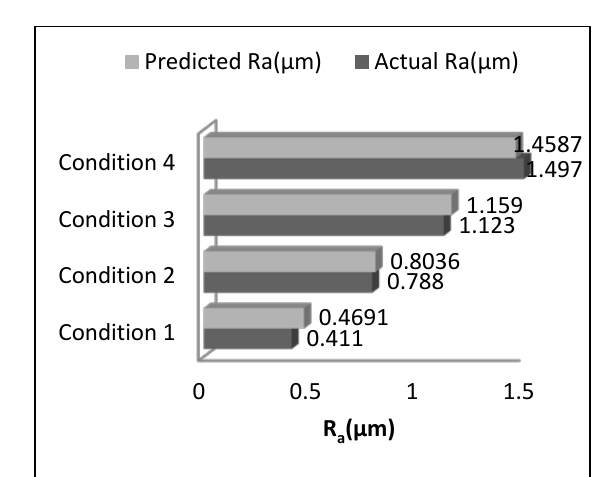
Fig. 7. Comparison of Ra values obtained from actual measurements and ANN method-(sample No. Vs. Ra (µm)) - For 5% Filler